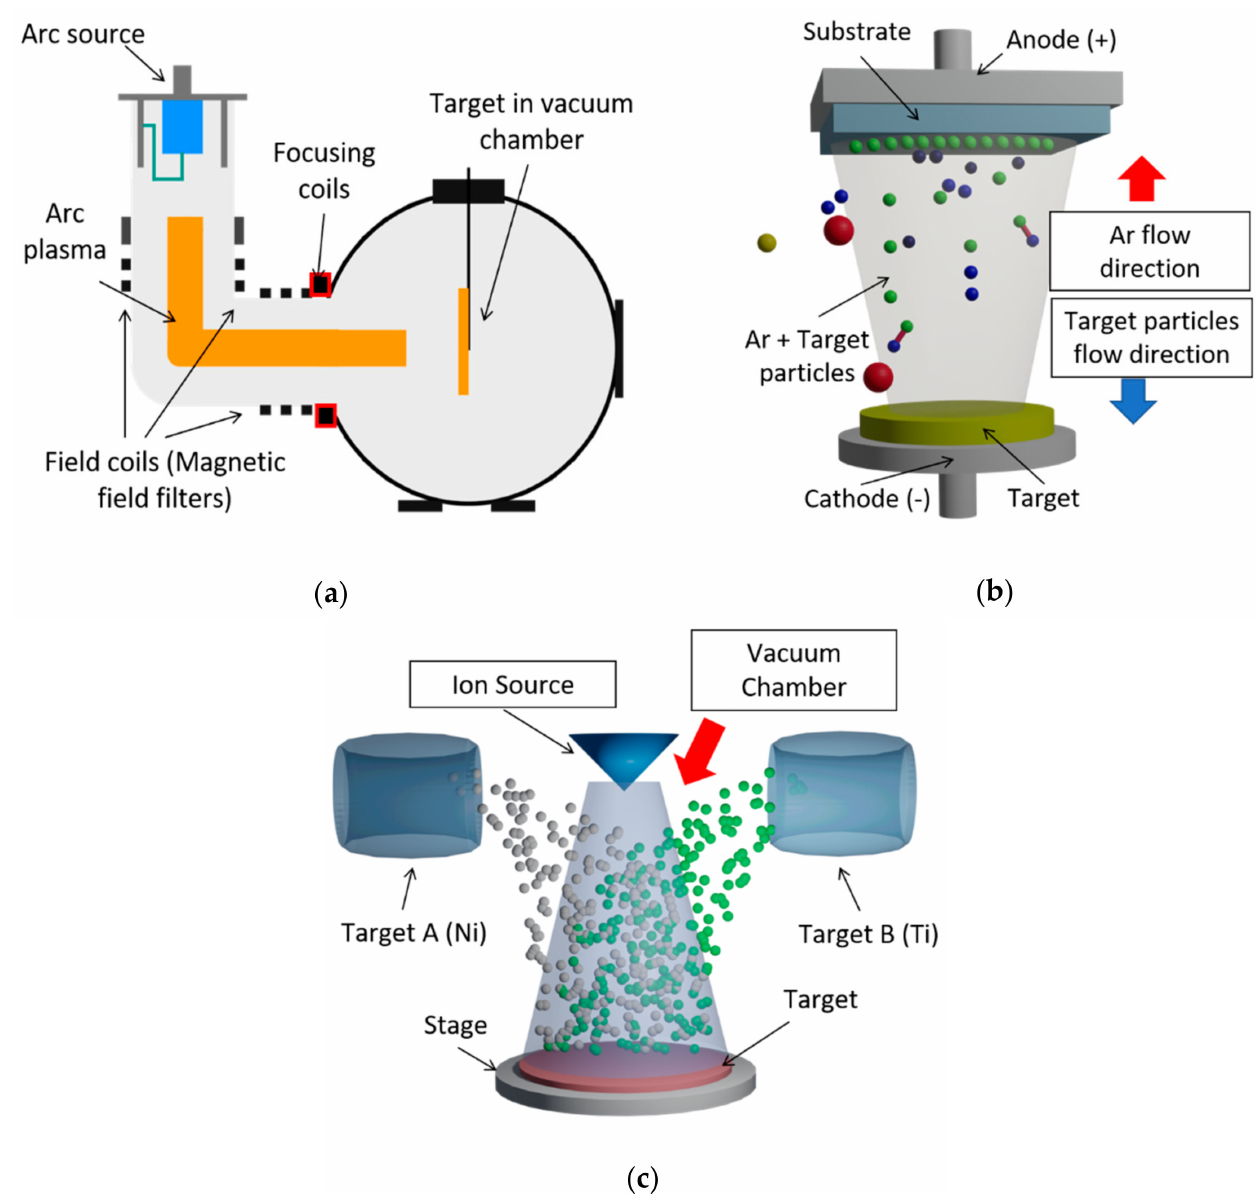
Figure 3. Standard deposition techniques used to prepare the majority of SMAs thin films ( a ) arc deposition, ( b ) magnetron sputtering, and ( c ) target ion beam